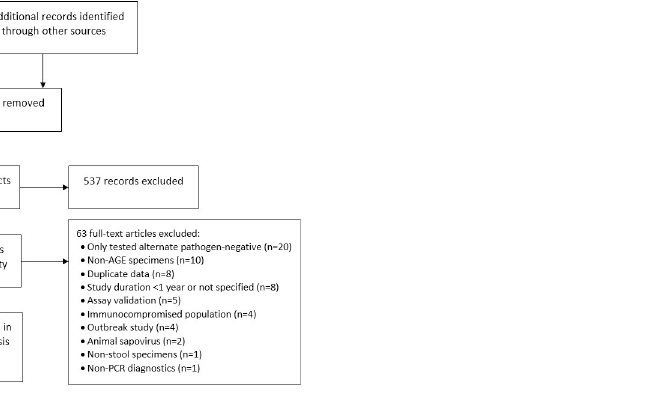
Fig 1. PRISMA flow diagram for study selection